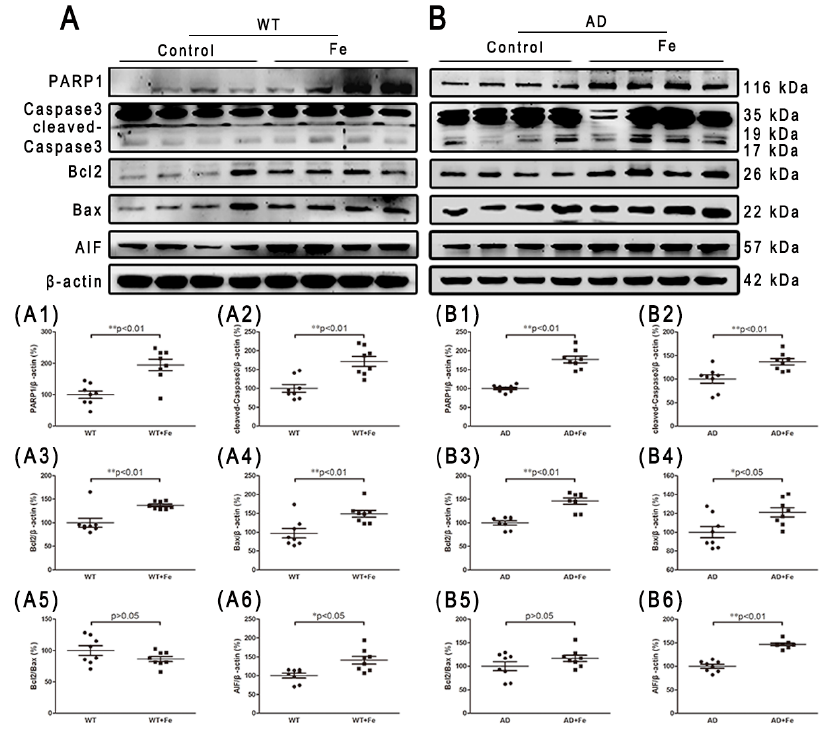
Figure 6. Changes in apoptosis-related proteins in the brains of HDI-treated mice. ( A , B ) Western blot analysis of PARP1, caspase 3, Bcl2, Bax, and AIF. ( A1 – A6 , B1 – B6 ) Quantitative analyses of Western blot for PARP1, caspase 3, Bcl2, Bax and AIF. β -actin was used as an internal control. All results are presented as the mean ± SEM ( n = 8). * p < 0.05, ** p < 0.01.